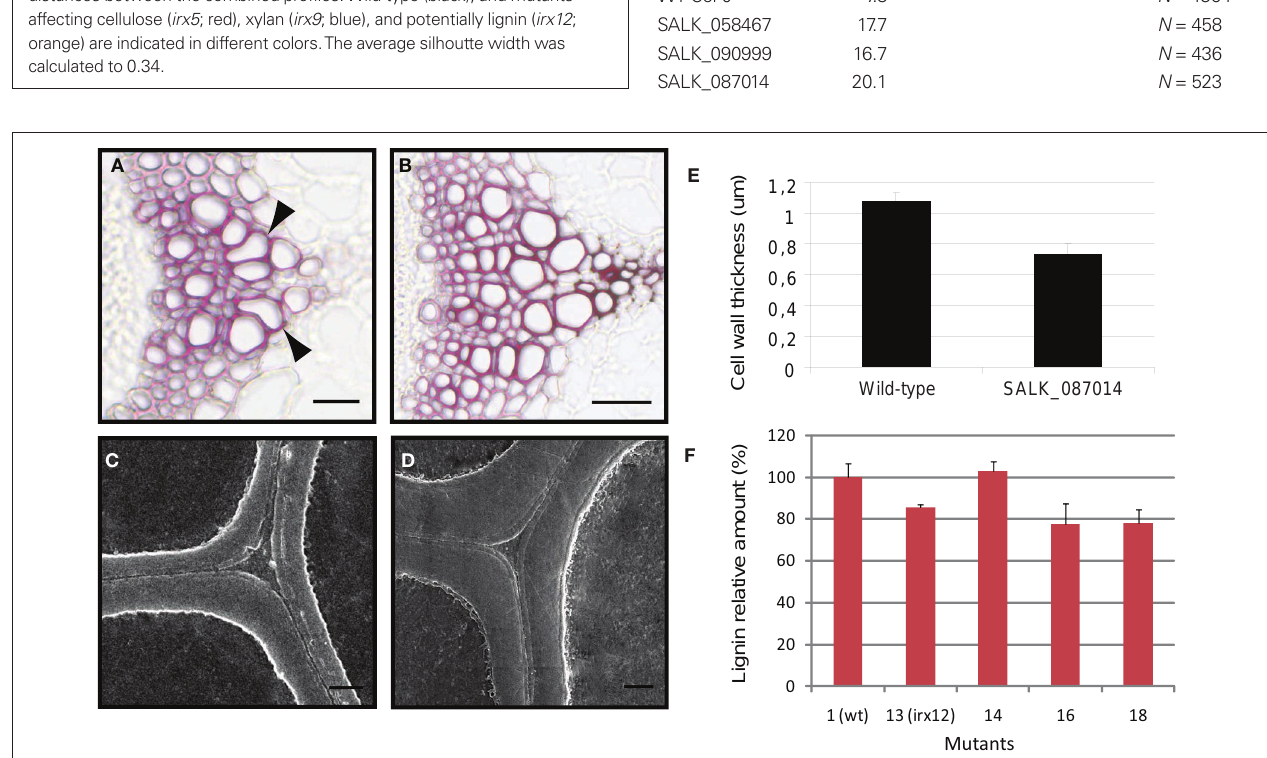
Figure 7 | Mutations in PRR1 cause disturbed xylem shapes, thinner secondary cell walls and a decrease in lignin related structures. (A,B) Example of stem sections stained with phloroglucinol–HCl for SALK_087014 (A) ; affecting PRR1 ) and wild-type (B) . Arrowheads indicate xylem vessels with disturbed morphology. Scale bars = 25 mm. (C,D) Secondary cell walls